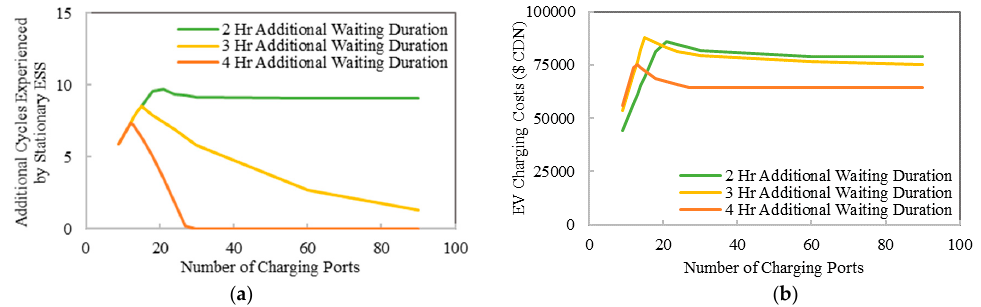
Figure 11. Comparison of ( a ) additional cycling imposed on stationary energy storage systems (ESS) and ( b ) additional operating costs imposed on the microgrid system by the EV fleet between different scenarios of allowable queuing